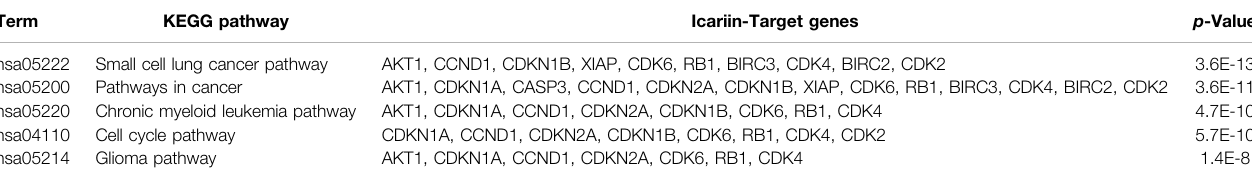
TABLE 2 | Top fi ve KEGG pathway and involved genes.